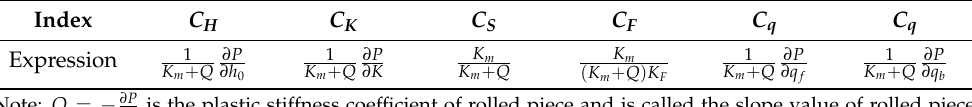
Table 1. Influence coefficients of some